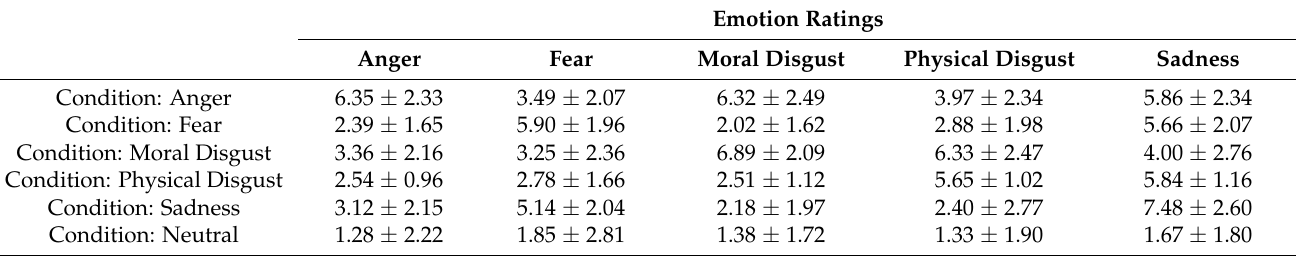
Table 5. Means and standard deviation of the emotional ratings across the six experimental conditions (Experiment 2).